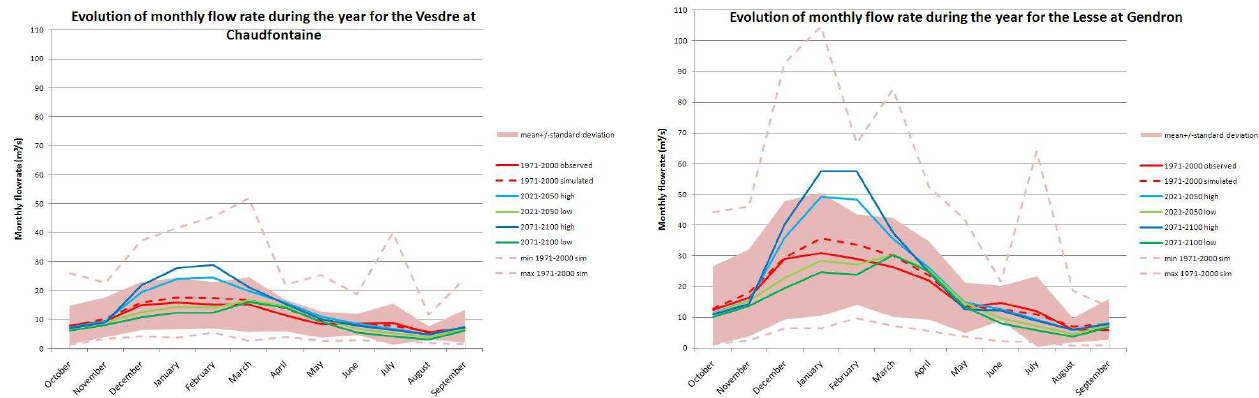
Fig. 4. Evolution of monthly flow during a year for the Vesdre at Chaudfontaine (upper panel) and the Lesse at Gendron (lower panel). The shaded areas represent the standard deviation for the reference period. Minimun and maximum represent the minimum and maximum values simulated during the reference